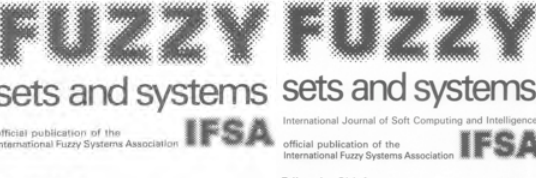
Fig. 1. Front pages of the volumes 68 (1994) and 69 (1995) of Fuzzy Sets and Systems ; since 1995 the subtitle has been “International Journal for Soft Computing and